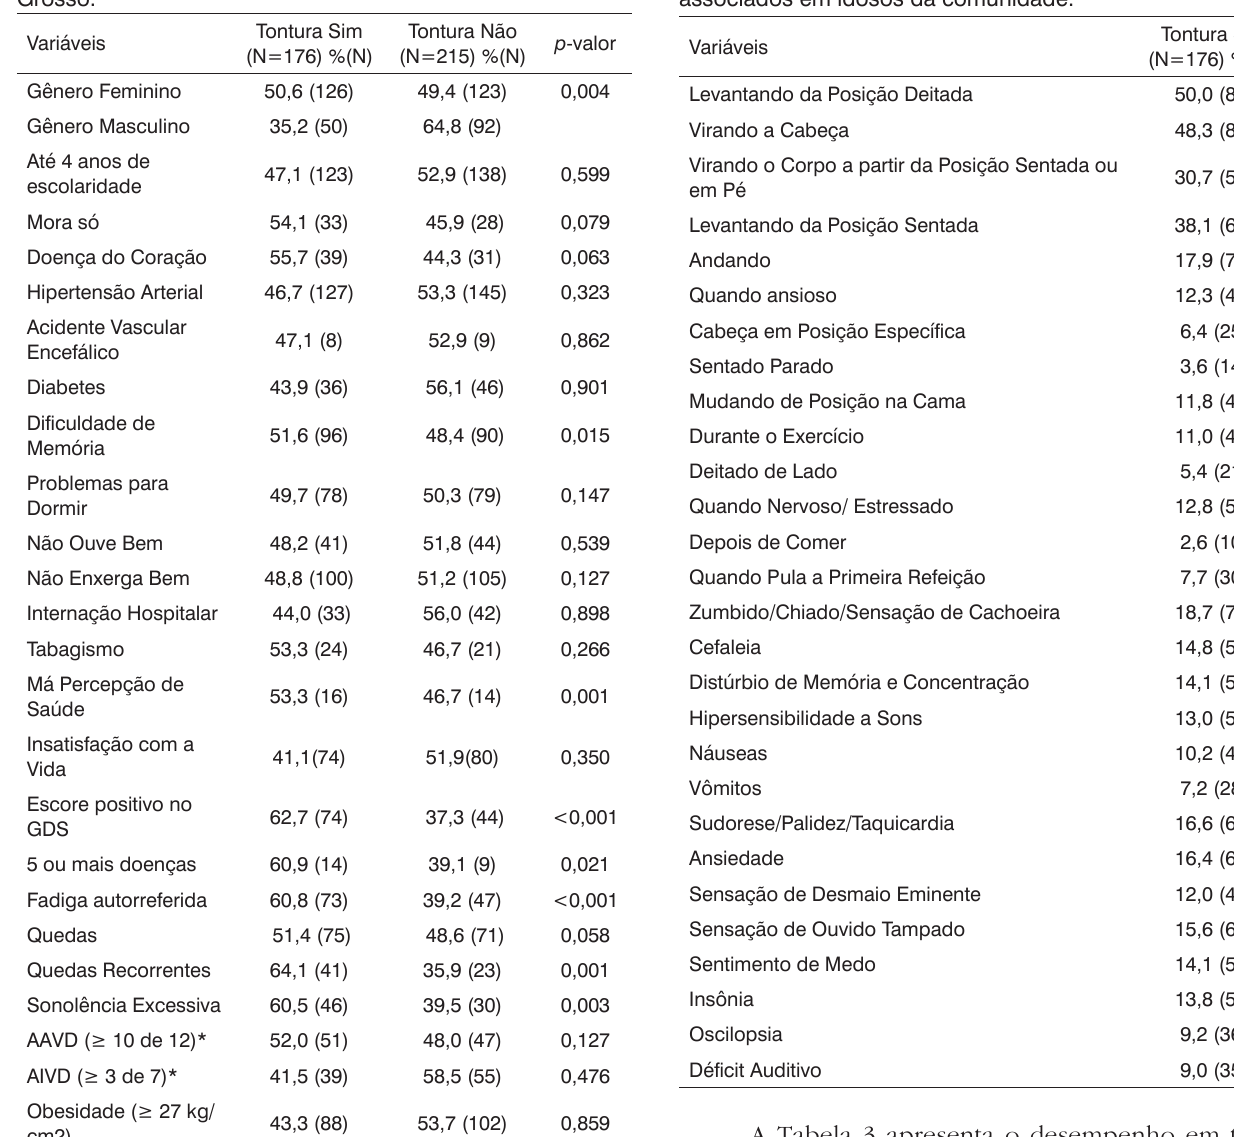
Tabela 2. Caracterização do quadro de tontura em relação às atividades e às principais posições desencadeantes e sintomas associados em idosos da comunidade.